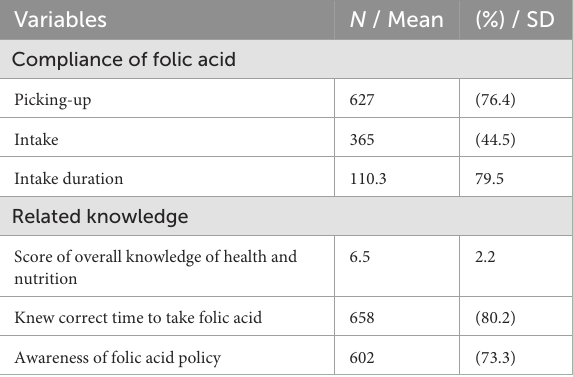
TABLE 2 Descriptive analyses of compliance of free folic acid supplements and related knowledge.